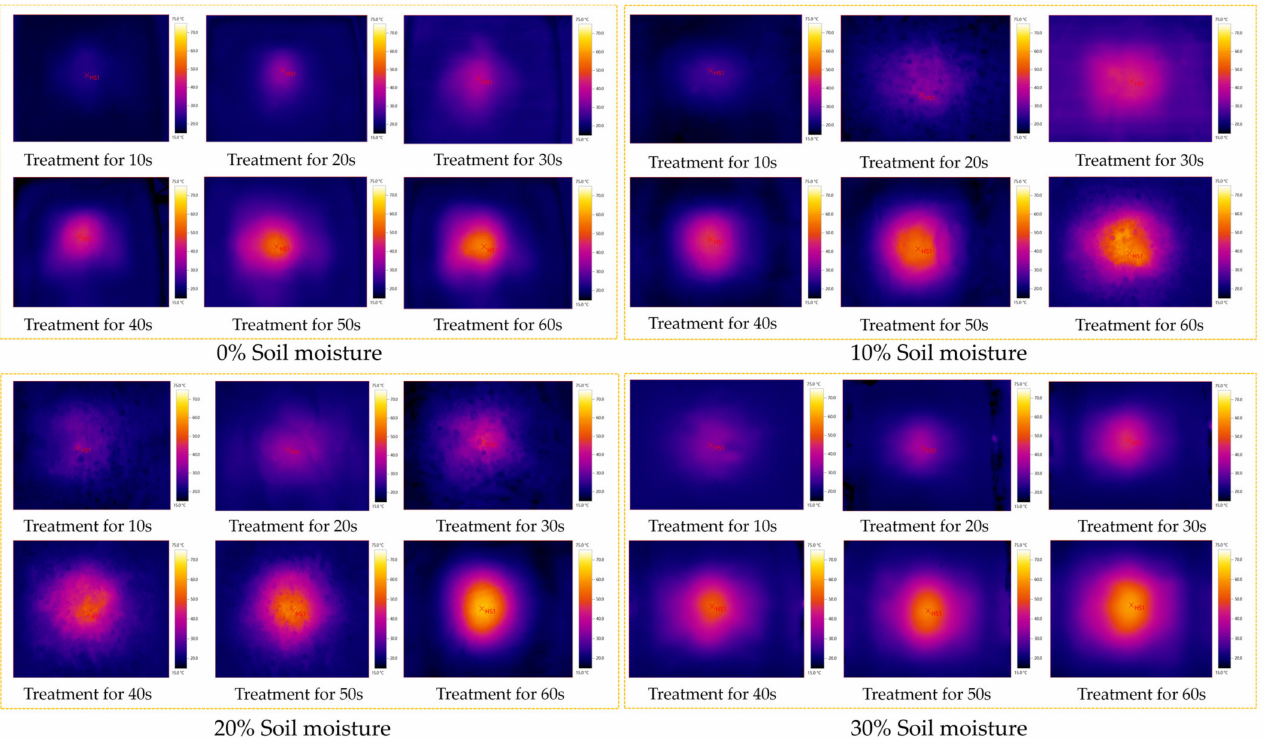
Figure 12. Thermal images of the soil surface at a microwave output power level of 1.6 kW.